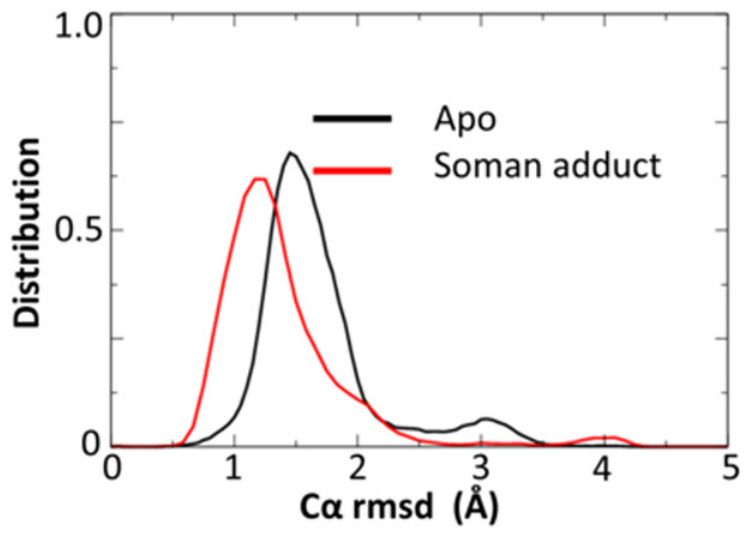
Fig 7. Comparison of motions of apo and soman-adducted hAChE. C α rmsd values for the Omega loop are shown. In the soman-adducted protein the Omega loop motions are significantly lower than those in the apo protein. A second peak at 3 Å in the apo structures suggests an additional conformation is